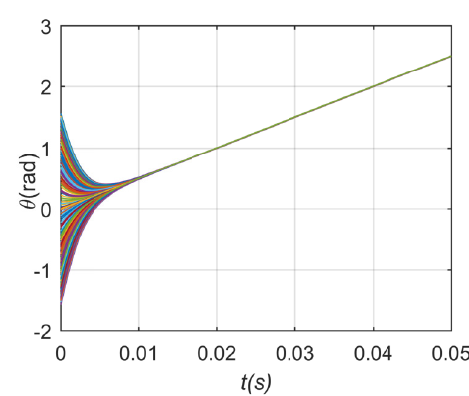
Figure 5. Phase stabilization process of undirected network in case